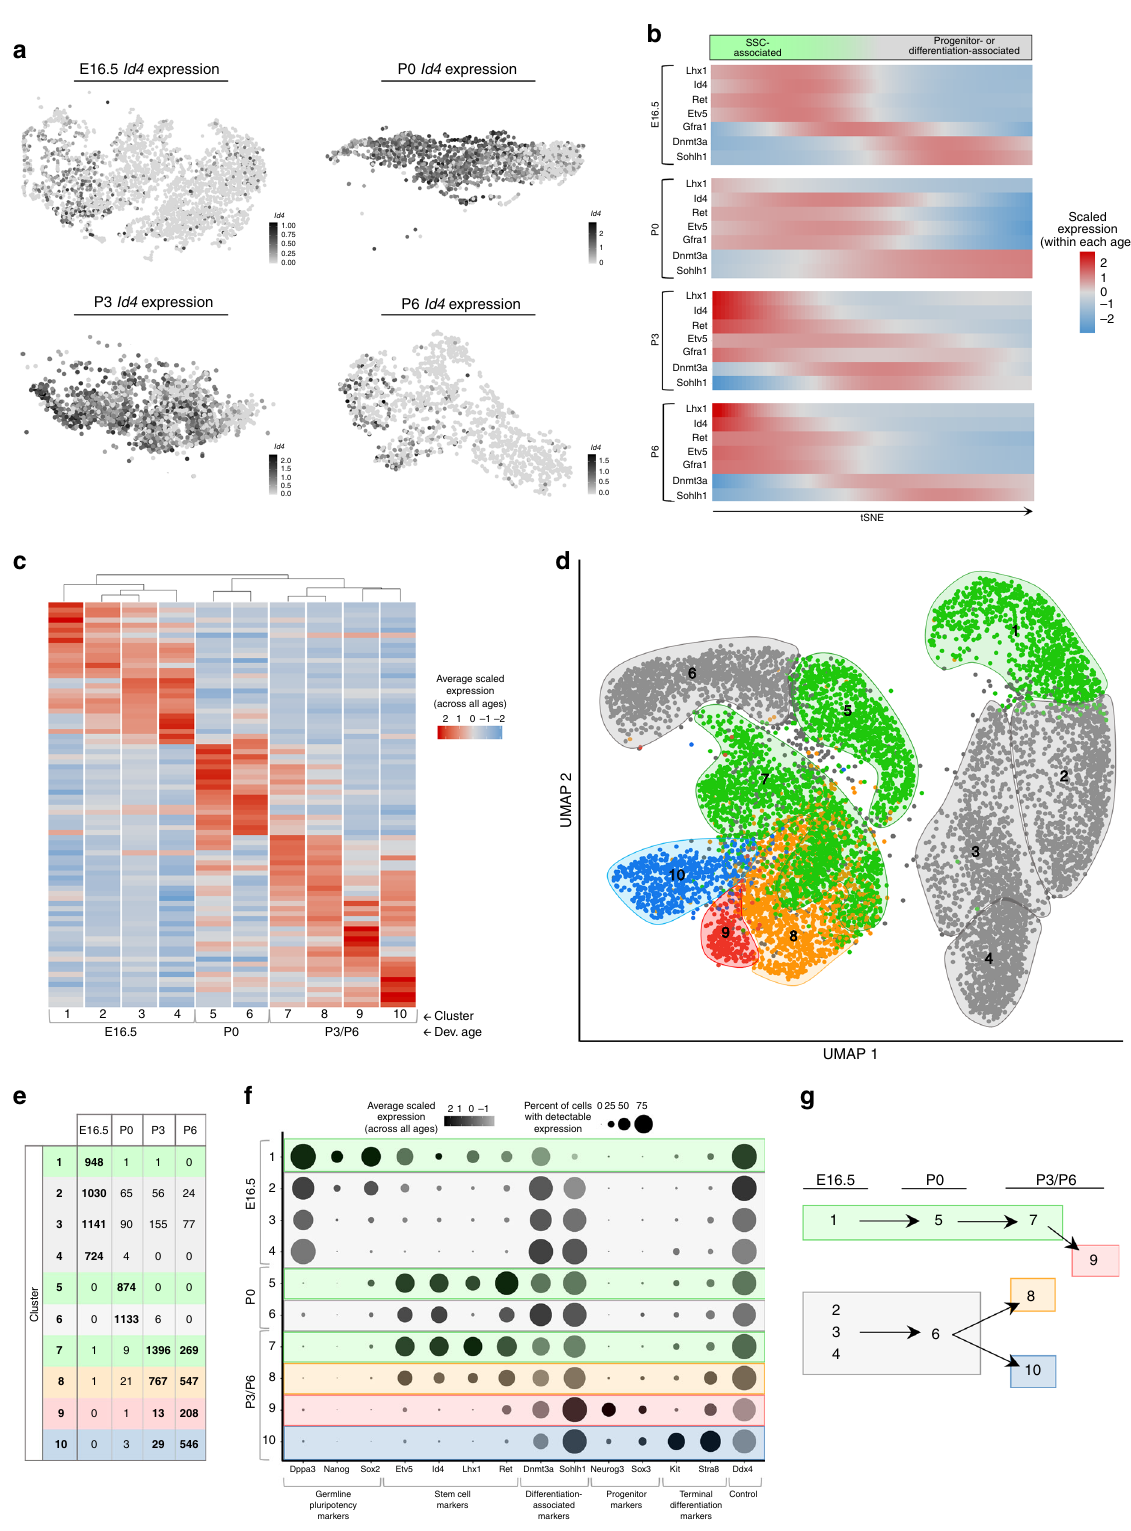
different mice across the four developmental ages. Individual 0.96 – 0.99 among replicates within each developmental age indi- transcriptomes were sequenced at an average depth of 127,675 cated highly consistent datasets. reads per cell representing moderate sequencing saturation Initial gene expression analysis of each developmental age by (62.6% average sequencing saturation). Together, the pooled tSNE distribution revealed heterogeneous Id4 expression con- libraries detected 20,325 mean genes per library and 20,546 sistent with in vivo transgene expression (Fig. 4a). Therefore, median UMI counts per cell. Modi fi ed Pearson ’ s correlations of based on the presence of population heterogeneity through NATURE COMMUNICATIONS| (2019) 10:2787